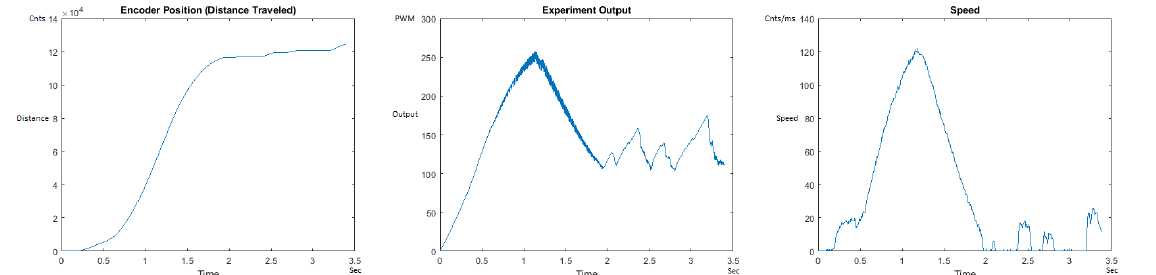
Figure 16. Encoder position, output and speed plots for PID++ UP operation— Vmax 120 cnts/ms, Adesired 0.040 cnts/ms 2 — 1 Kg.